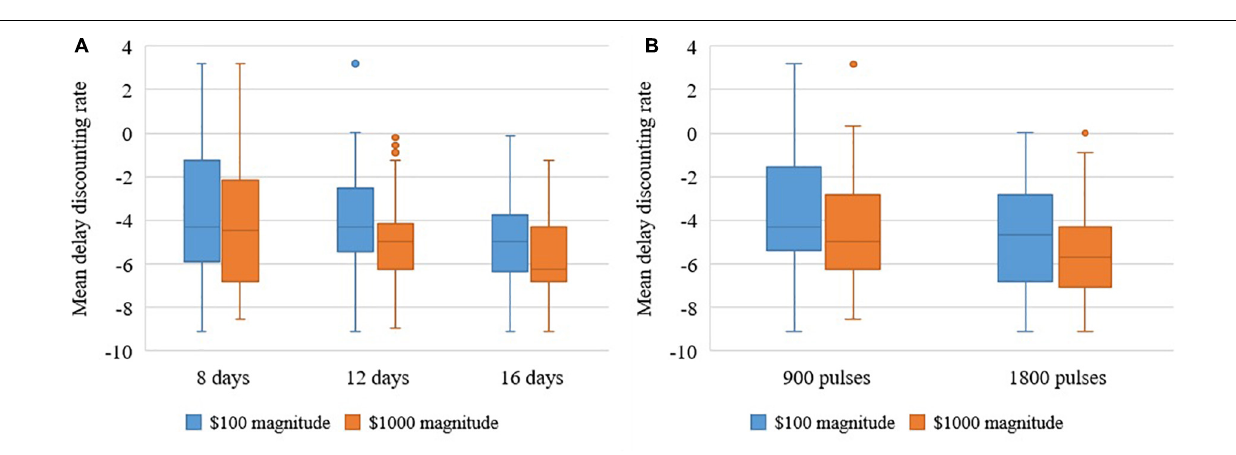
FIGURE 2 | (A) Repeated measures analysis of variance shows that increasing duration decreases delay discounting rates of $100 and $1000 overall over 6 months. (B) Repeated measures analysis of variance shows that increasing intensity decreases delay discounting rates of $100 and $1000 overall over 6